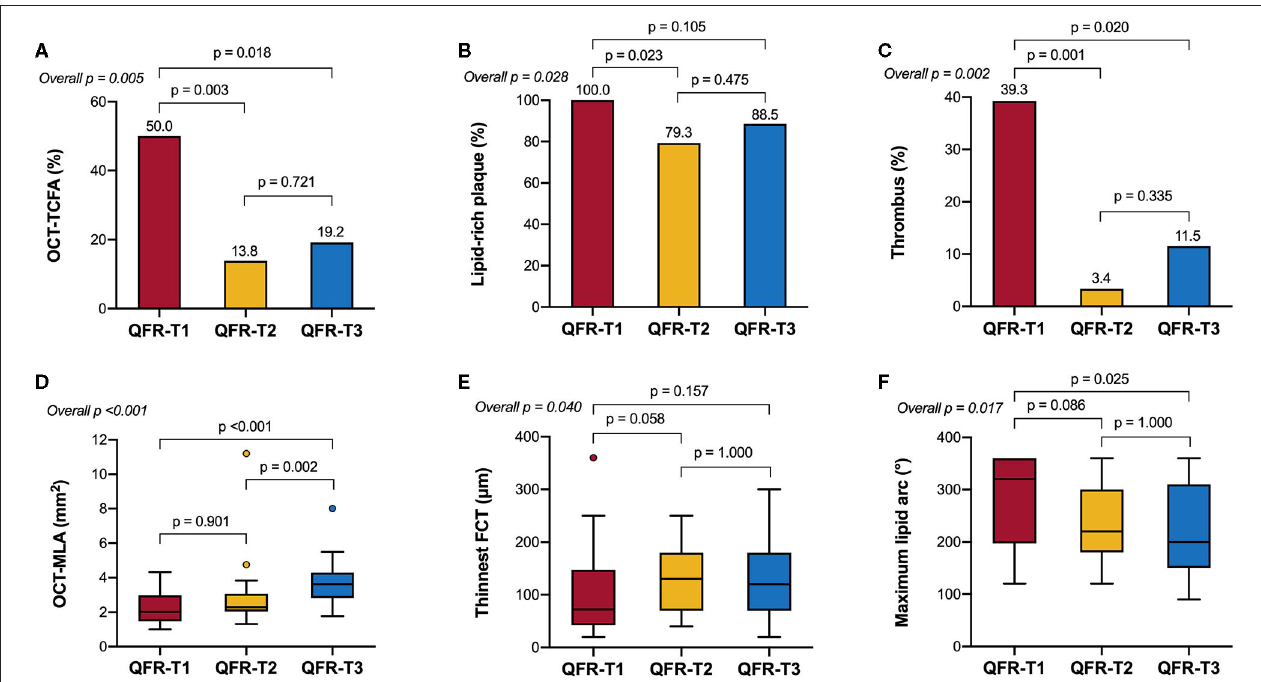
FIGURE 3 | OCT-derived morphological characteristics stratified by QFR tertiles. (A) The prevalence of OCT-TCFA was the highest in QFR-T1; however, it was not significantly different between QFR-T2 and QFR-T3. (B) The prevalence of lipid-rich plaques was the highest in QFR-T1, although no significance was observed in pairwise comparisons after Bonferroni adjustment. (C) Compared with the other tertiles, thrombosis is more likely to occur in QFR-T1. (D) QFR-T3 had a significantly larger OCT-MLA than the other tertiles. (E) There was an overall difference in the thinnest FCT among tertiles but no pairwise comparison was significant. (F) The maximum lipid arc was significantly different among tertiles. FCT, fibrous cap thickness; OCT-MLA, optical coherence tomography-minimal lumen area; other abbreviations as in Figure 1